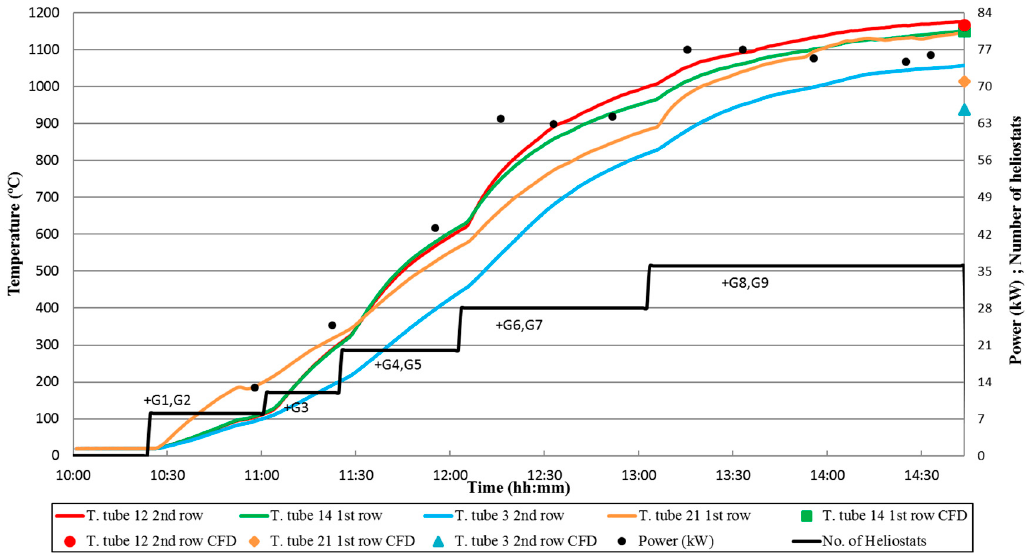
Figure 10. Evolution of temperatures for experimental test and CFD temperature results. T. tube corresponds to the thermocouple inside the tubes, in contact with ferrites. Number of heliostats focused on the receiver and the power measured.